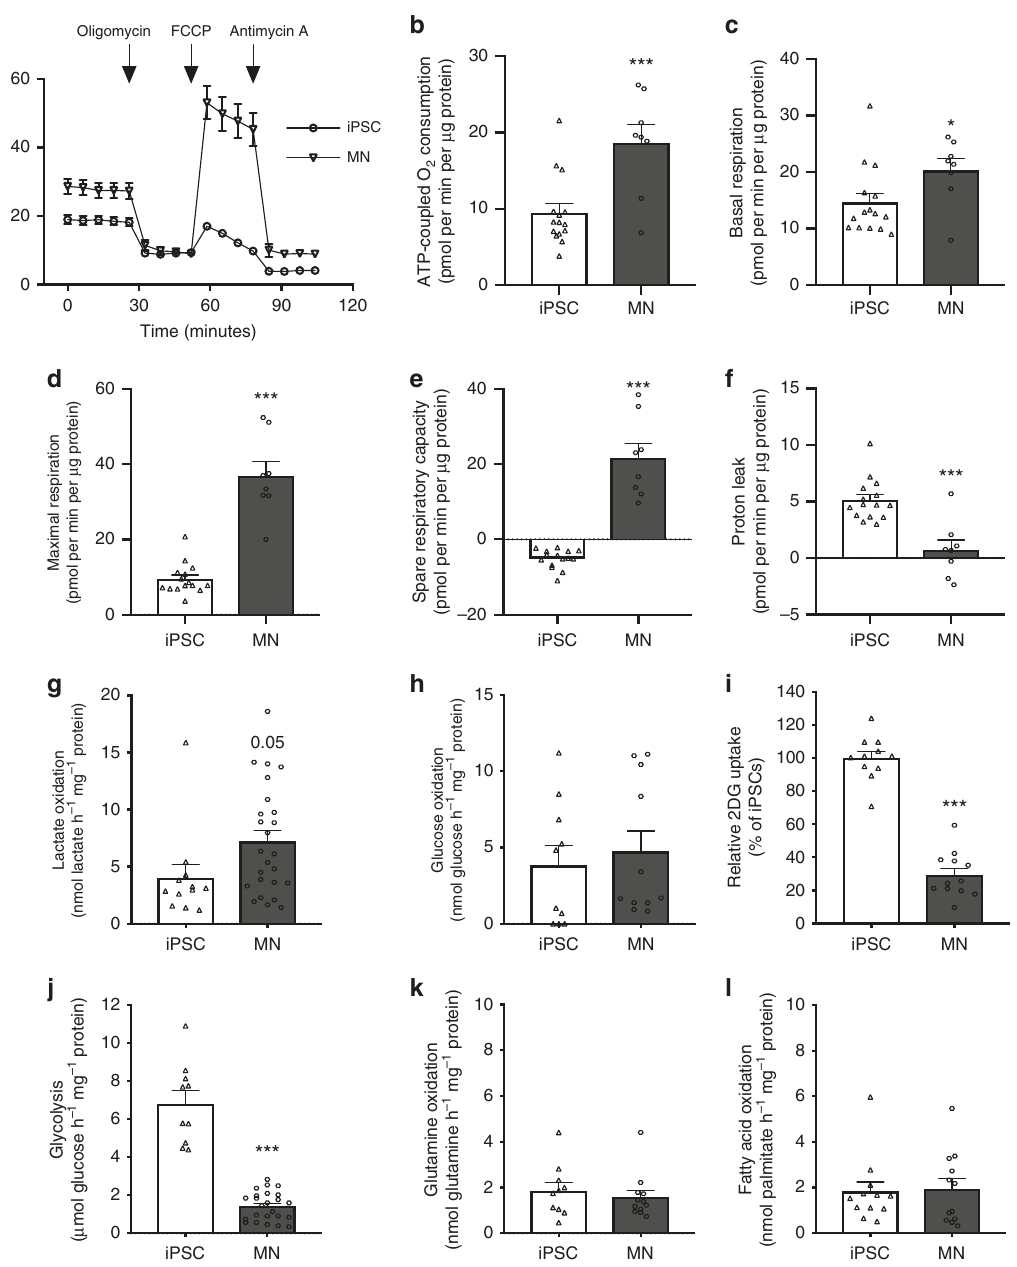
Fig. 3 Mitochondrial respiration and metabolic fl ux in human iPSCs and MNs. a Overview of the oxygen consumption rate (OCR) throughout the mitochondrial respiration test in human iPSCs and motor neurons. Arrows indicate the time when mitochondrial inhibitors where added to the media to assess respiratory parameters. b ATP-coupled oxygen consumption was determined by inhibiting ATP synthase using oligomycin. c Basal respiration in iPSCs and motor neurons. d Maximal respiration was assessed following mitochondria uncoupling by FCCP. e Spare respiratory capacity was determined by subtracting basal respiration from maximal respiration in iPSCs and motor neurons. f Proton leakage in both cell types was determined after inhibiting complex III via antimycin-A. g Lactate oxidation in iPSCs and motor neurons. h Glucose oxidation in iPSCs and motor neurons. i Glucose uptake in iPSCs and motor neurons. j Glycolytic fl ux in iPSCs and motor neurons. k Glutamine oxidation in iPSCs and motor neurons. l Fatty acid oxidation in iPSCs and motor neurons. ** p < 0.01, *** p < 0.0001. Statistical analyses were performed by two-tailed t tests to compare iPSCs and motor neurons in panel b – l . The data represent mean ± s.e.m. from four control cell lines from three independent experiments, with individual data points shown. Source data are provided as a source data fi le. iPSC induced pluripotent stem cell, MN motor neuron, OCR oxygen consumption rate, FCCP carbonyl cyanide ‐ 4 ‐ (tri fl uoromethoxy) phenylhydrazone, 2DG 2-deoxy-glucose